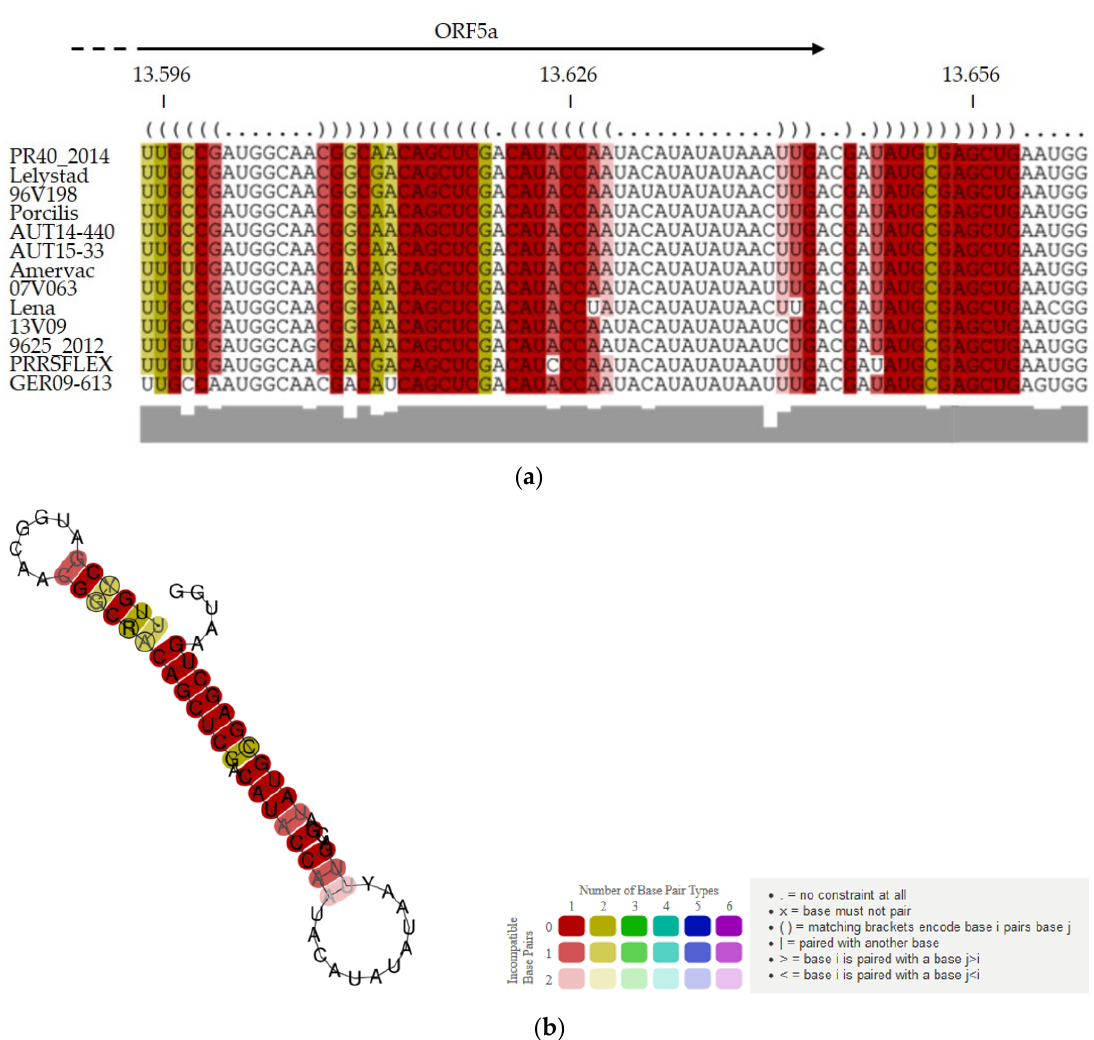
Figure 4. Predicted RNA folding of PRRSV sequence alignments. ( a ) Alignment and ( b ) predicted RNA folding of putative stem loop within ORF5 of several PRRSV-1 vaccines (Porcilis ® PRRS, Amervac ® PRRS, Ingelvac PRRSFLEX ® EU) and wild-type strains. Figures were created with Lo- cARNA version 1.9.1.